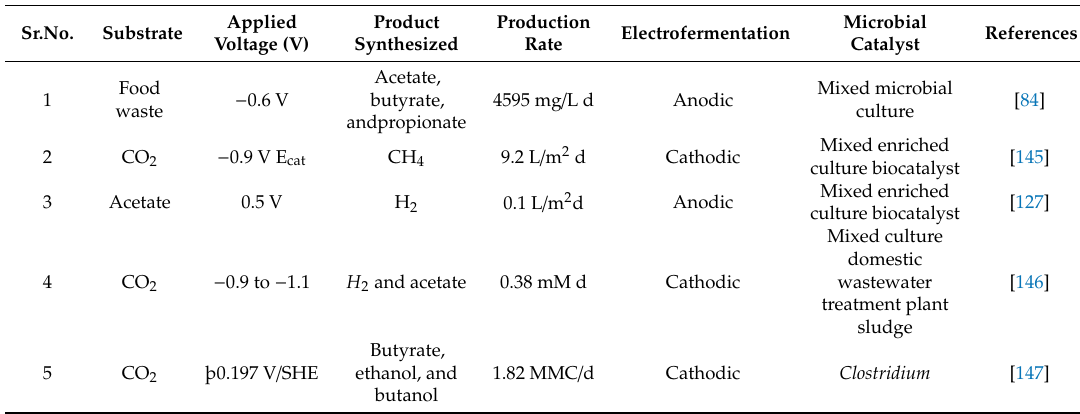
Table 1. Operating parameters for specific product formation